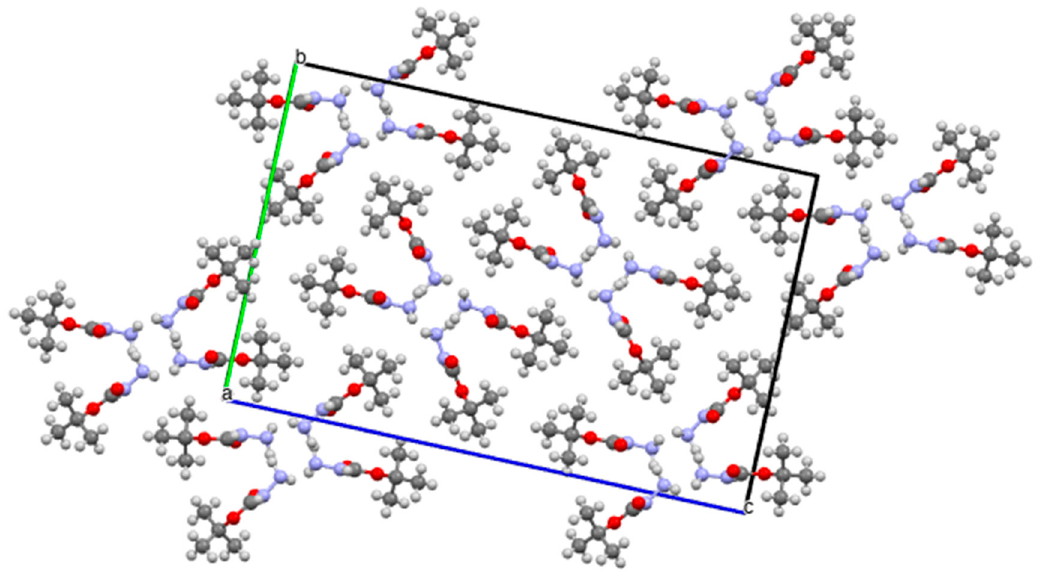
Figure 3. Packing pattern of sets of four independent molecules, showing orthogonal pairs and the 16 molecules within the unit cell viewed along the a axis.